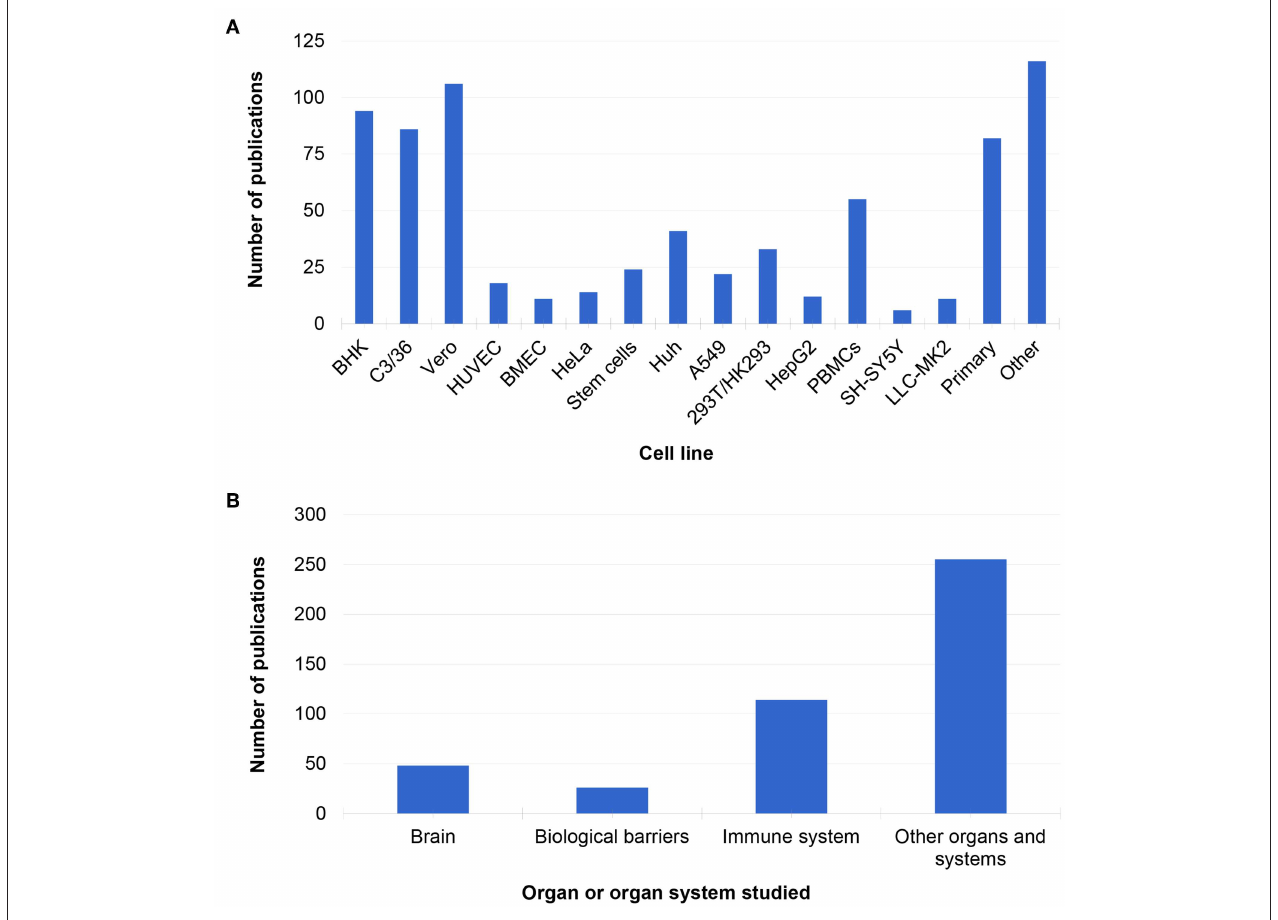
FIGURE 2 | Cell lines (A) and organs and systems (B) represented in the in vitro